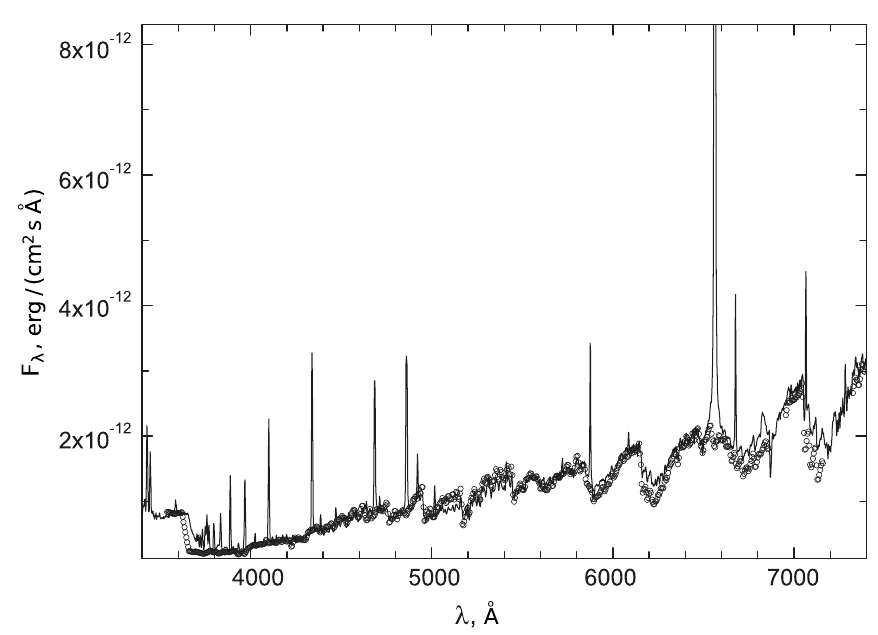
Fig. 3. Quiescent spectrum of AG Peg taken on 2011 August 6 and the model curve (open